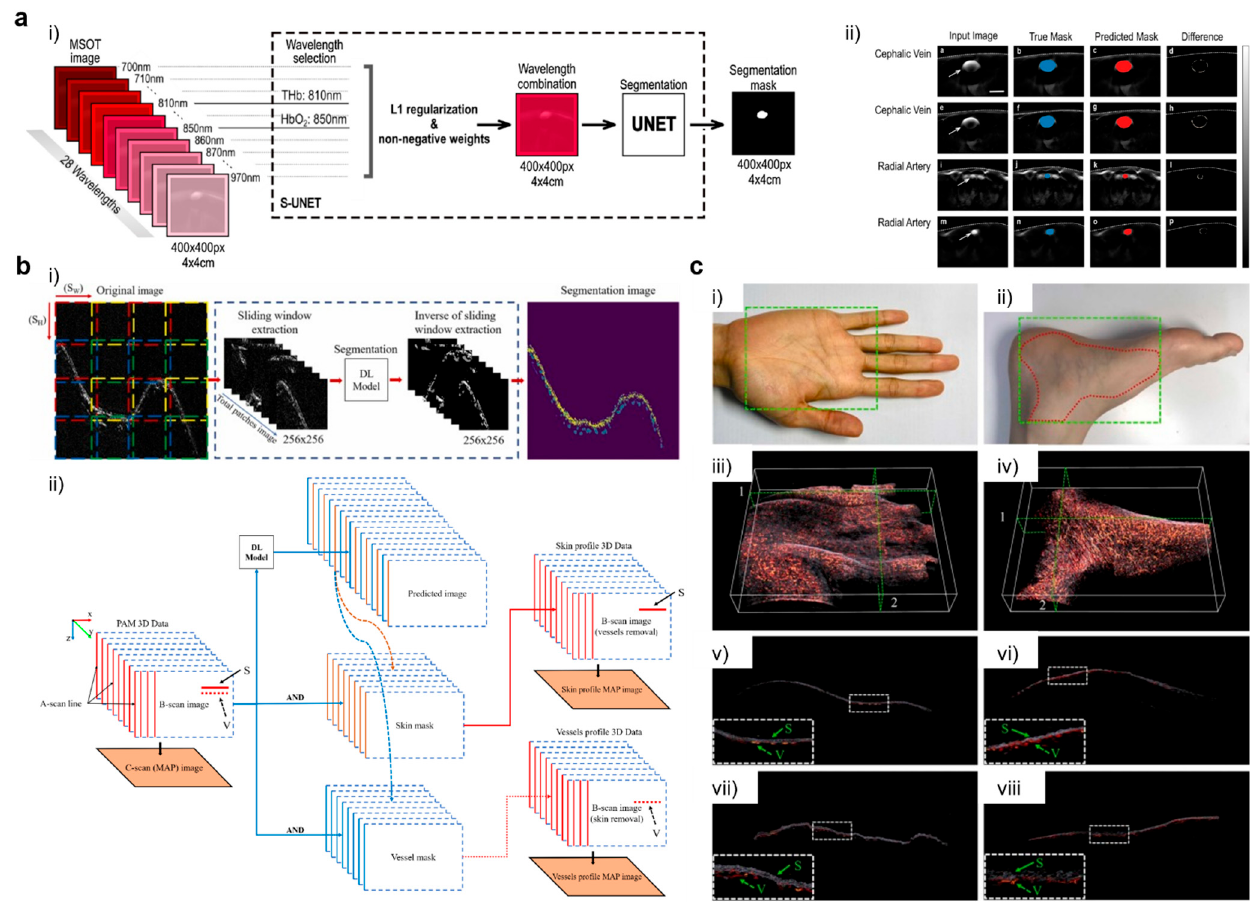
Figure 4. ( a ) (i) The S-UNET workflow identified illumination wavelengths; (ii) the results